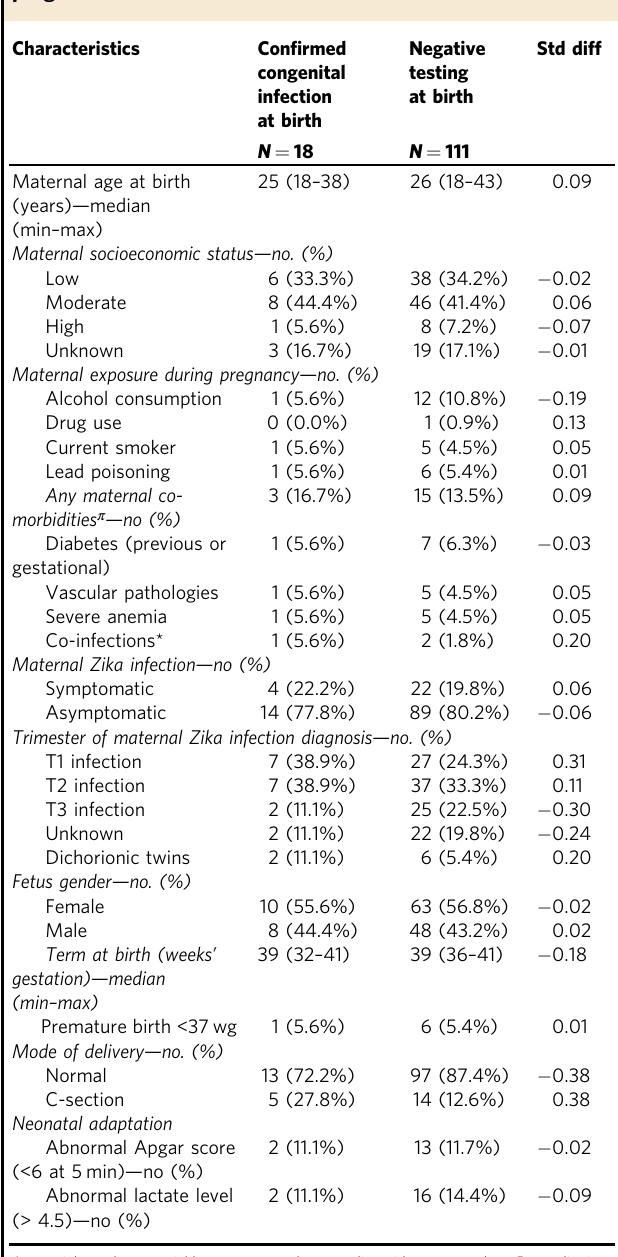
Table 1 Baseline characteristics of ZIKV-exposed pregnancies and